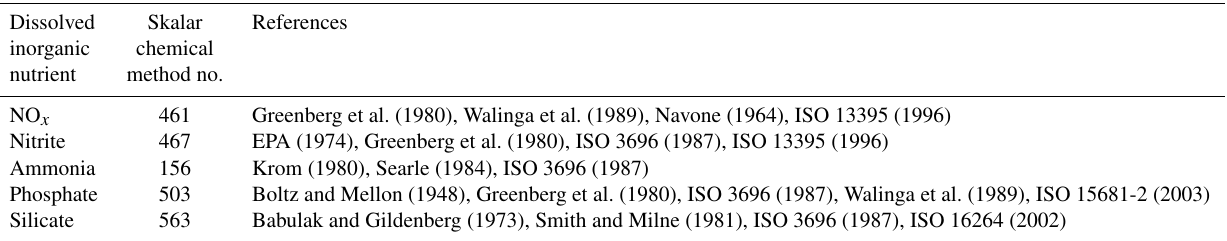
Table 2. Chemical methods applied to measure dissolved inorganic nutrient concentrations in the water samples. NO x : total oxidized nitro- gen.